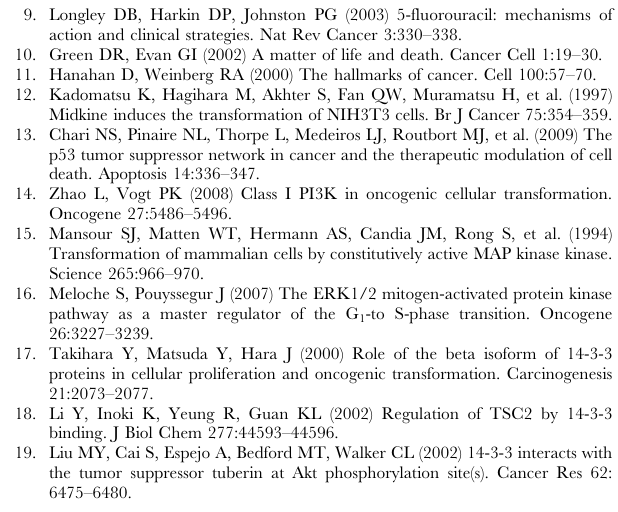
Figure S4 Three cancer cell lines HeLa-NC-shRNA, HeLa-OVA66-shRNA-1 and -2 cells were deprived of serum for 24 hr ahead of adding 10% FBS for 0 min and 15 min. Cell lysates were then probed with 4G9, p/T-AKT, p/ T-ERK1/2 and GAPDH antibodies by WB. Figure S5 Cell proliferation of NIH3T3-mock and NIH3T3-flagOVA66 cells treated with DMSO, LY294002 and PD98059 was detected by CCK-8 analysis every 24 h after cells were seeded in a 96-well plate. The data are mean 6 SEM (n